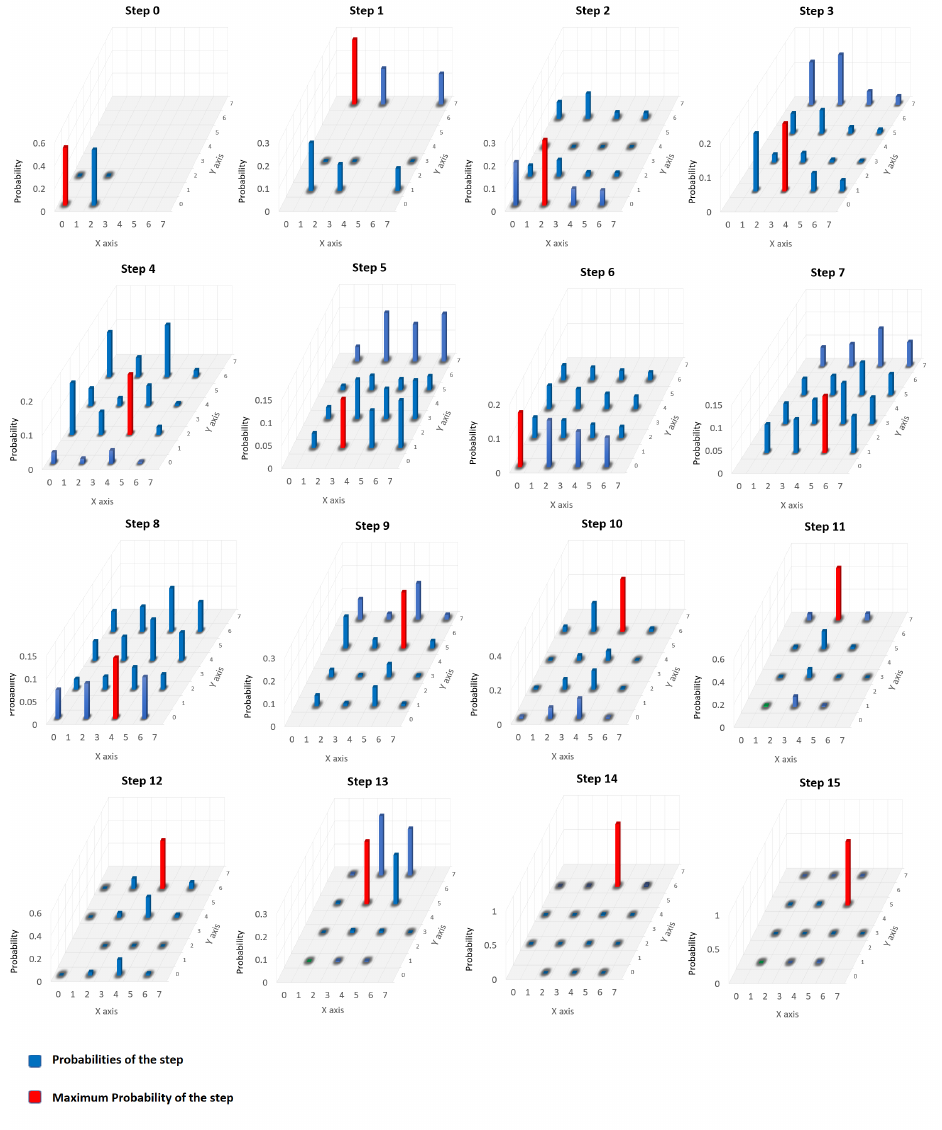
Figure 21. The representation of the probabilities of the best individual for CQGA. The evolution of the solution search is given in Table